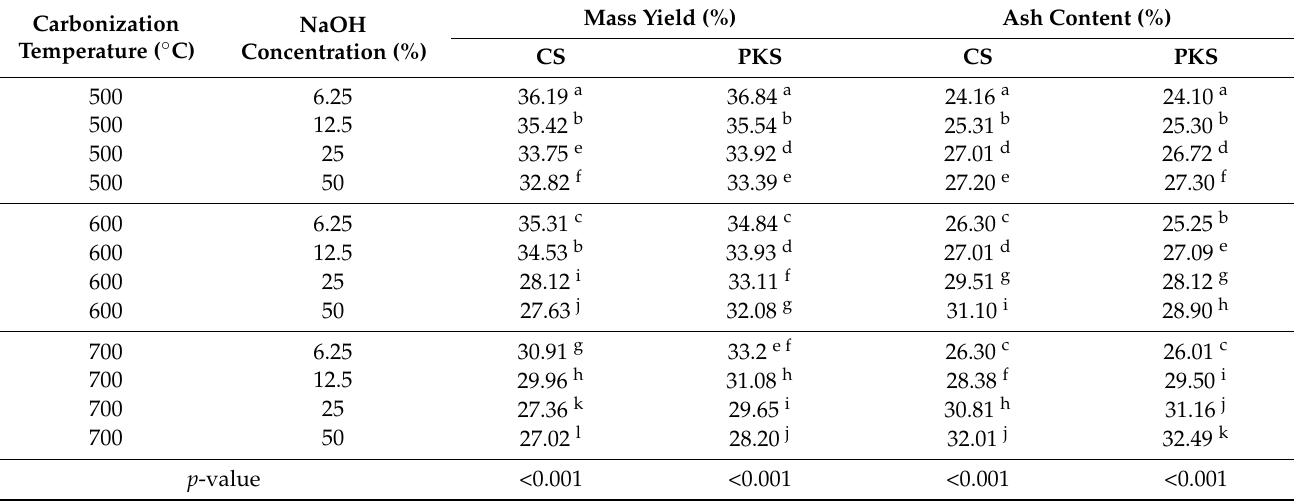
Table 2. ANOVA for the mass yield and ash content of activated